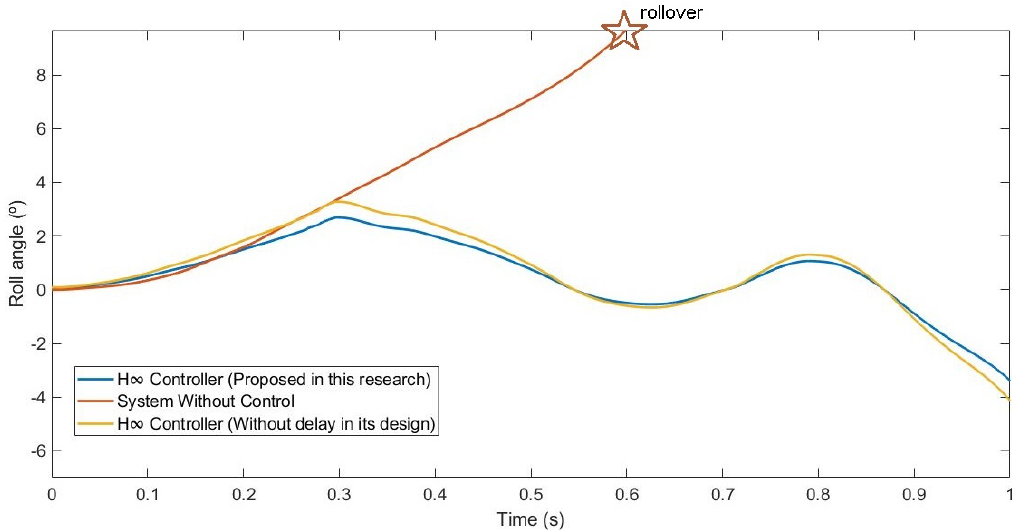
Figure 21. Roll angle for test 3: Roundabout at 120 km/h.